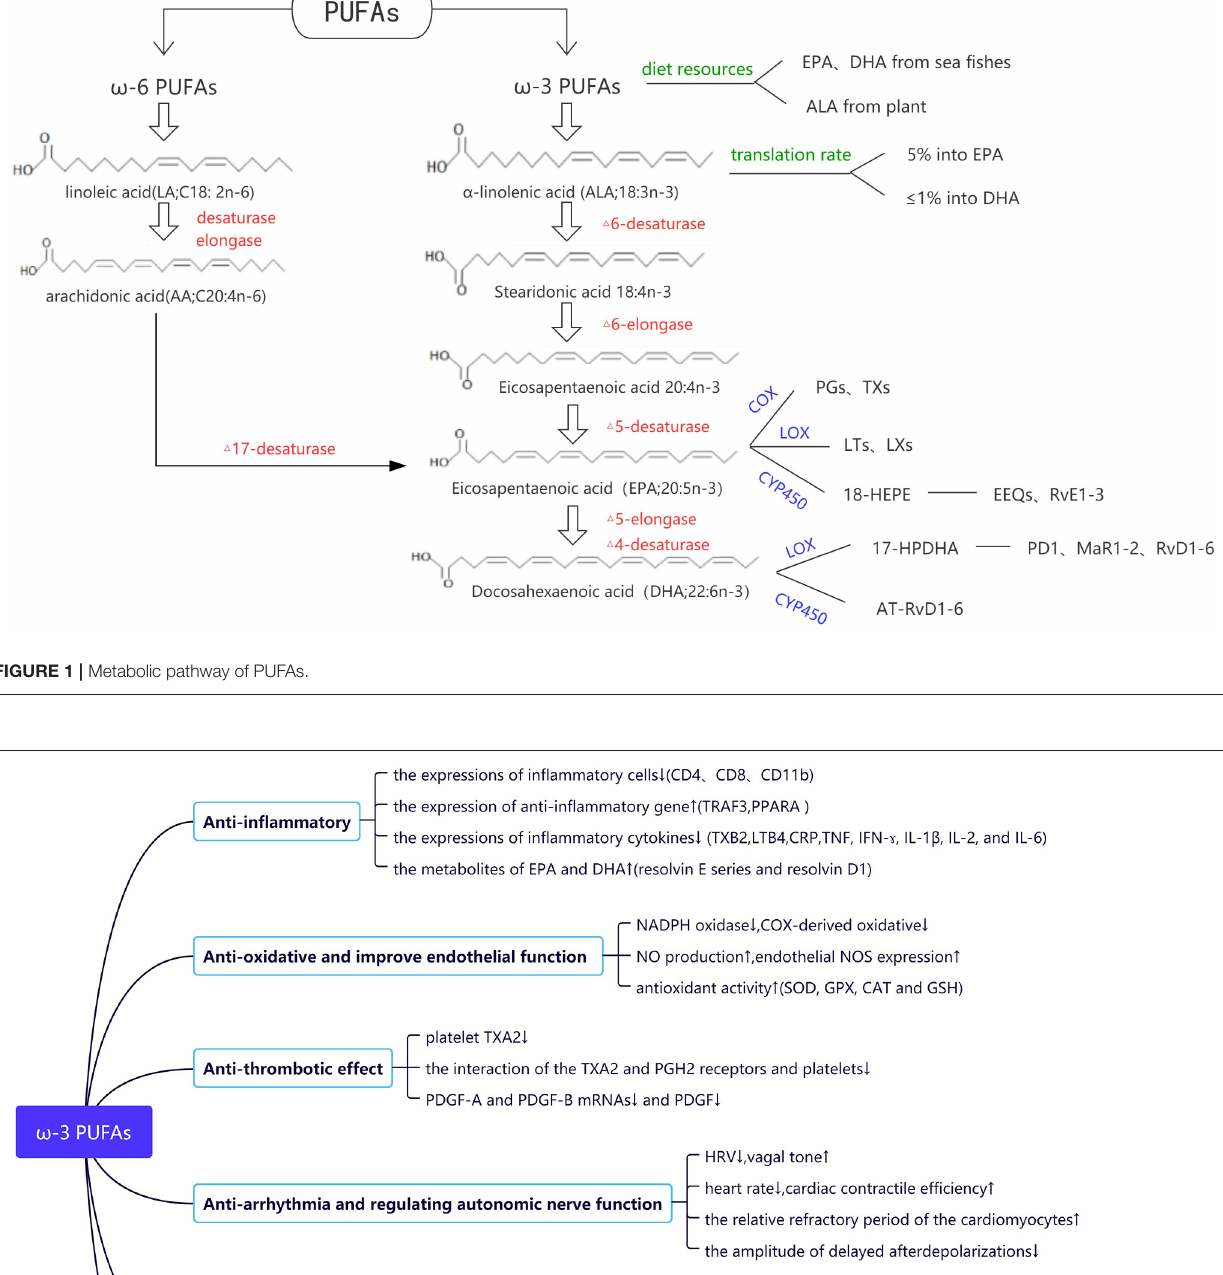
Frontiers in Cardiovascular Medicine |